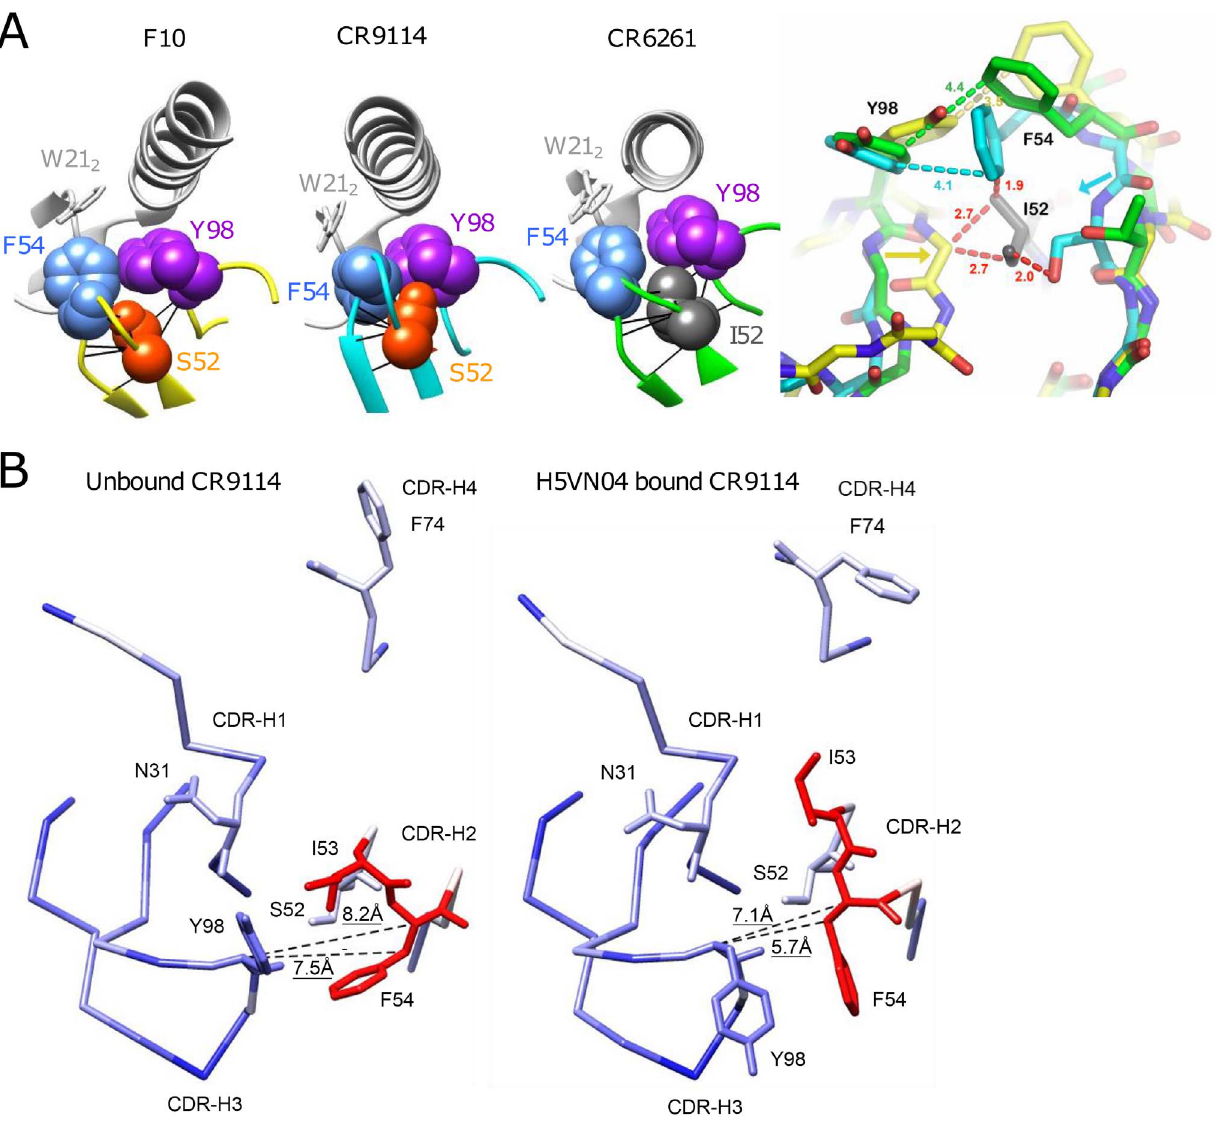
Figure 6. Understanding the structural role of the distinctive CDR-H2 amino acid substitutions in HV1-69-sBnAbs. A) VDW contact analysis (black lines) shows that Ser52 of F10 and CR9114 (orange), and Ile52 of CR6261(gray) make only intramolecular contacts; i.e., do not form contacts with their respective H5VN04s. Antibodies are shown in color; HA is in light gray. At far right, steric consequences of the germline Ile52 and the Ile52Ser substitutions are shown when the Abs are overlaid on their framework residues (RMSD , 0.5 A˚). Comparing structures of the HV1-69- sBnAbs, centered on Ile52 of CR6261 (green), with F10 (yellow) and CR9114 (cyan), the Ile52Ser mutation in F10 and CR9114 enables the 2 strands to come closer together, as indicated by the yellow and cyan arrows. Distances in red indicate hypothetical steric clashes ( , 3 A˚) that would be created if Ile52 were present in CR9114 and F10. B) Comparison between the unbound (PDB 4FQH, left) and H5VN04-bound structures (PDB 4FQI, right) of CR9114, colored according to the magnitude of structural change after superposition on the main-chain of the VH domain (from blue=0 A˚, through white=1 A˚, to red=1.8 A˚). CDRs and side-chains of the major contact residues are shown, as depicted in Figure 1A. Distances between the C a and C b atoms of Phe54 and the C a atom of CDR-H3 Tyr98 (shown as dashed lines) are indicated. Large rotations of the side chains of CDR-H3 Tyr98, CDR- H2 Phe54 and CDR-H2 Ile53 are also evident, as previously noted [7]. clustered at positions 97-to-99 ( Figure 2A ). Interestingly, six of the seven V-segment substitutions arise in CDR positions that are sparse in AID SHM motifs (WR CY/RGYW) ( Figure 3B–D ). Therefore, these mutations were generated by either error-prone long patch BER and MMR processes or by random SHM events. In addition, HV1-69-sBnAbs characterized by Gly52a are shown to associate with double or triple CDR-H3-Tyr and those characterized by Ala52a that are strongly associated with Arg30 and appear to represent unique molecular signatures for a subset of HV1-69-sBnAbs.